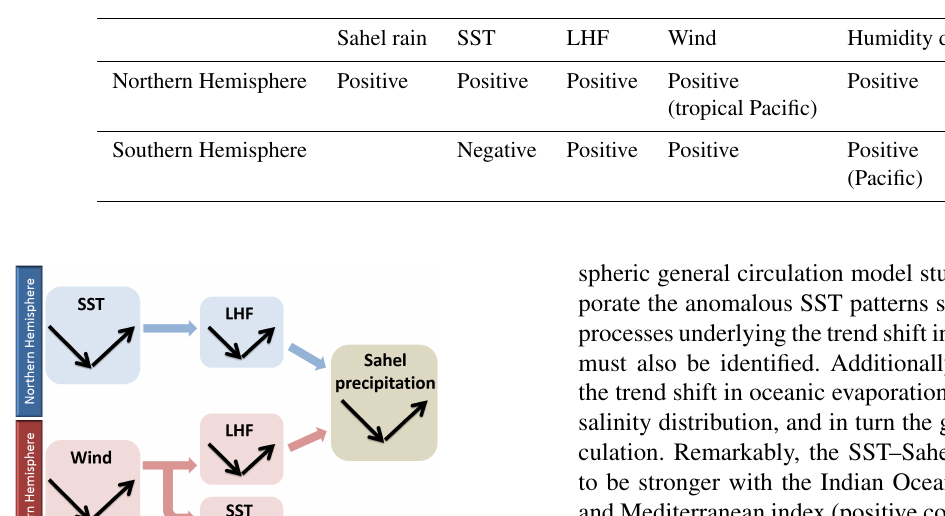
Table 1. Summary of results for JAS meteorological parameters. “Positive” indicates that a shift from decrease to increase occurred during 1950 to 2012; “negative” indicates a shift from increase to decrease.